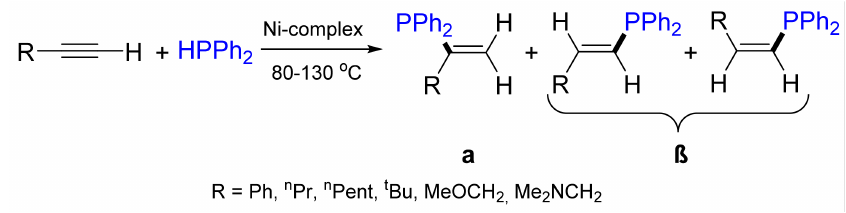
Figure 15. Nickel-catalyzed addition of HPPh 2 to alkynes.